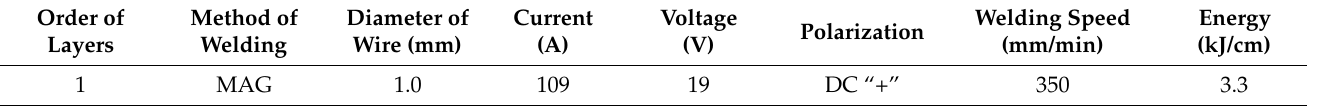
Table 1. Sample welding details.